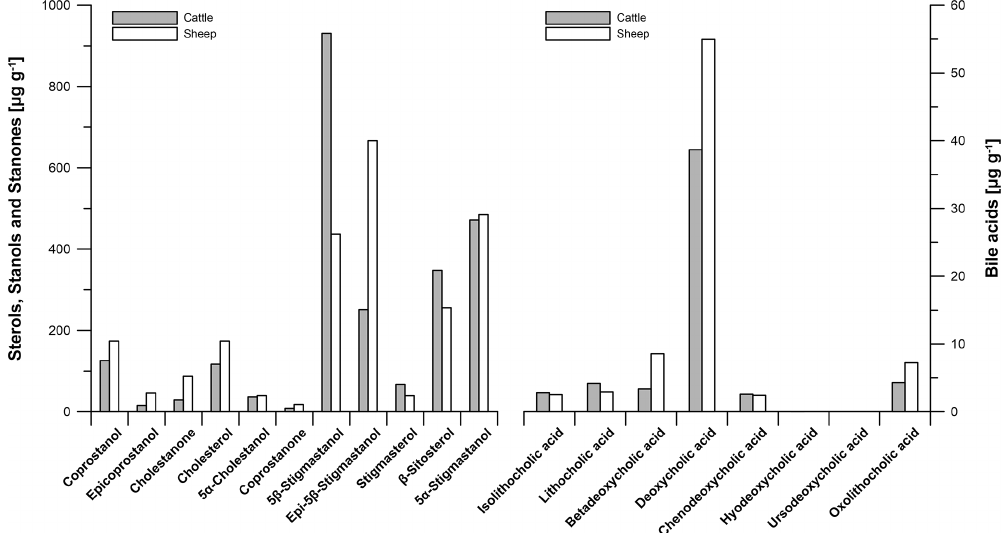
Figure 4. Biomarker patterns of modern faeces from predominant livestock at the prehistorical encampment site of Ullafelsen in the Fotsch Valley, Stubai Alps, Austria, and it surroundings. Steroid (sterols, stanols, stanones and bile acids) contents of cattle and sheep faeces are given in micrograms per gram of dry